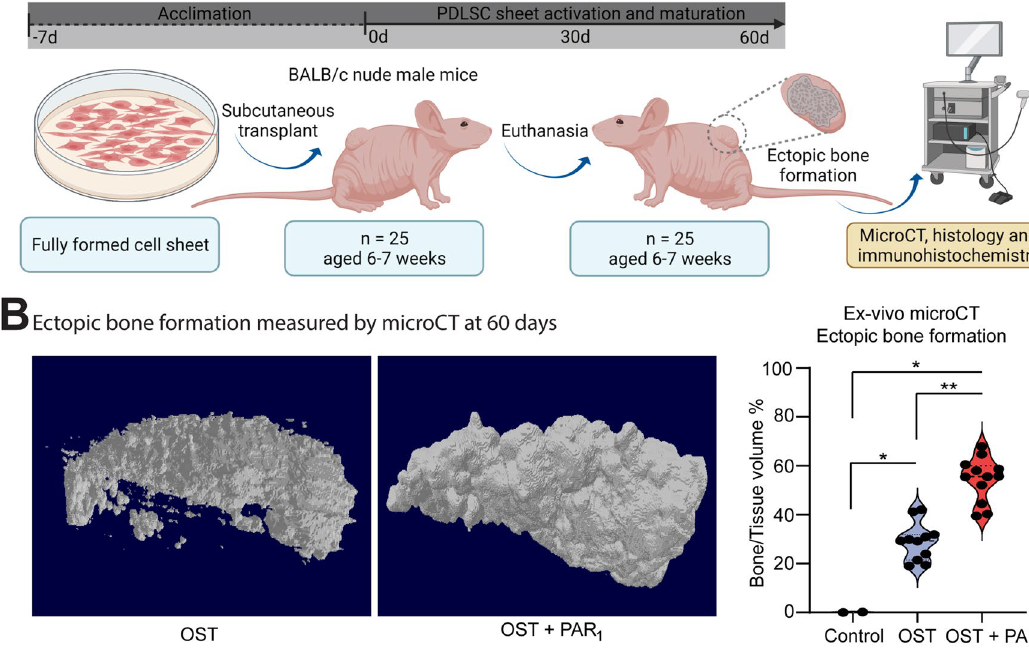
Figure 3. ( A ) Cell sheets in vivo transplant and ex-vivo analysis workflow. ( B ) Micro-CT analysis of ectopic bone formation in vivo after 60 days of transplantation ( B ) and the statistical analysis comparing the BV/TV% between the 3 groups CTRL, OST and OST + PAR 1 . (*) means a p < 0.05 compared to control. Results are given as the mean ± SD. Figure ( A ) was created using